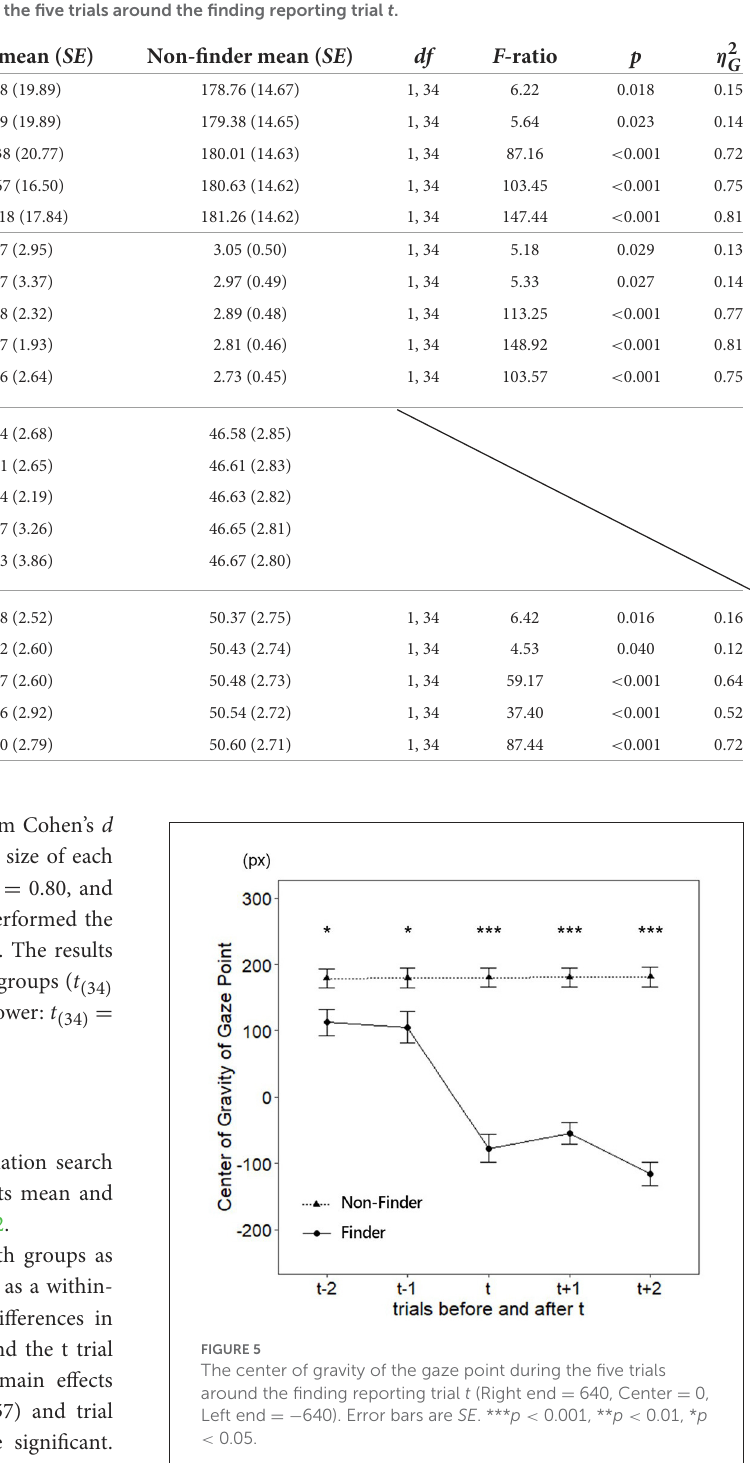
region was significantly greater in the finders than in the non- finders, not only in the t and after t trials but also before the t